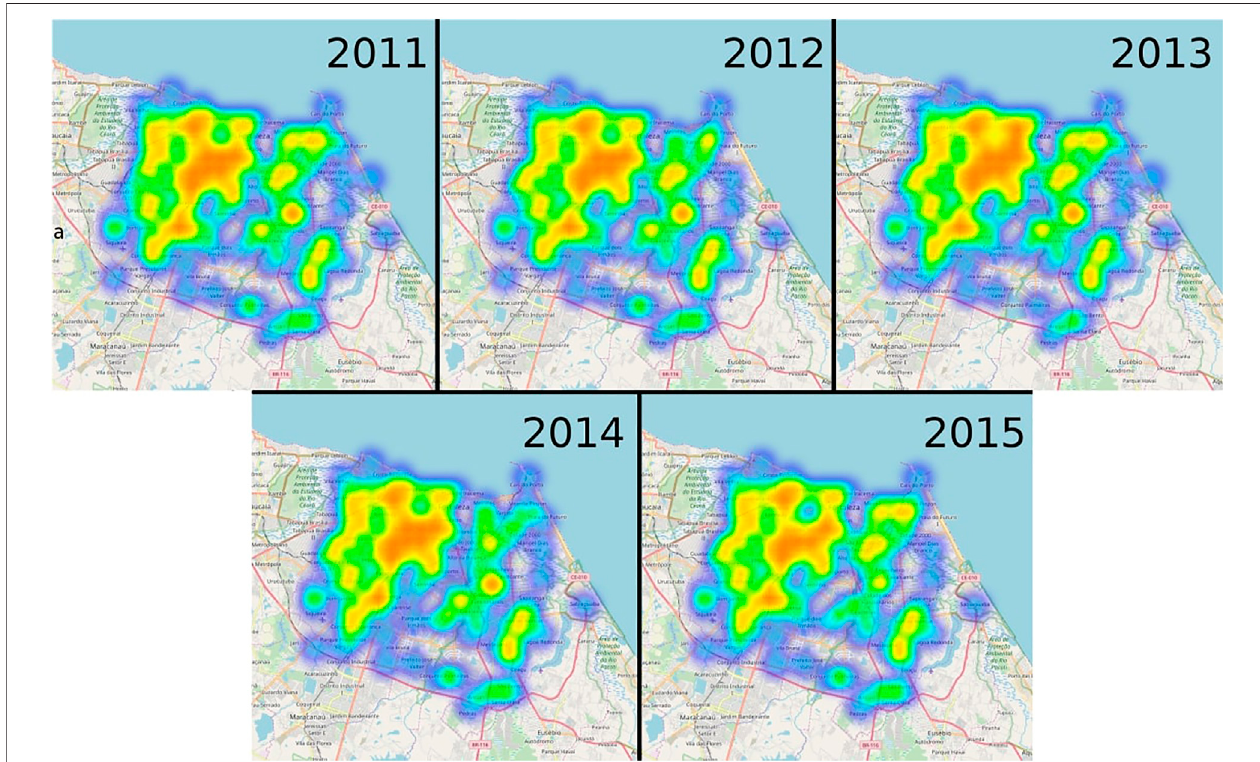
FIGURE 3 | Positive SPs in Fortaleza from 2011 until 2015. Heat maps of the larvae measurement outcomes in Fortaleza from 2011 until 2015. If larvae are found, the SP measurement is said to be positive. Blue areas correspond to regions with a low number of positive SPs, whereas red ones indicate the opposite.